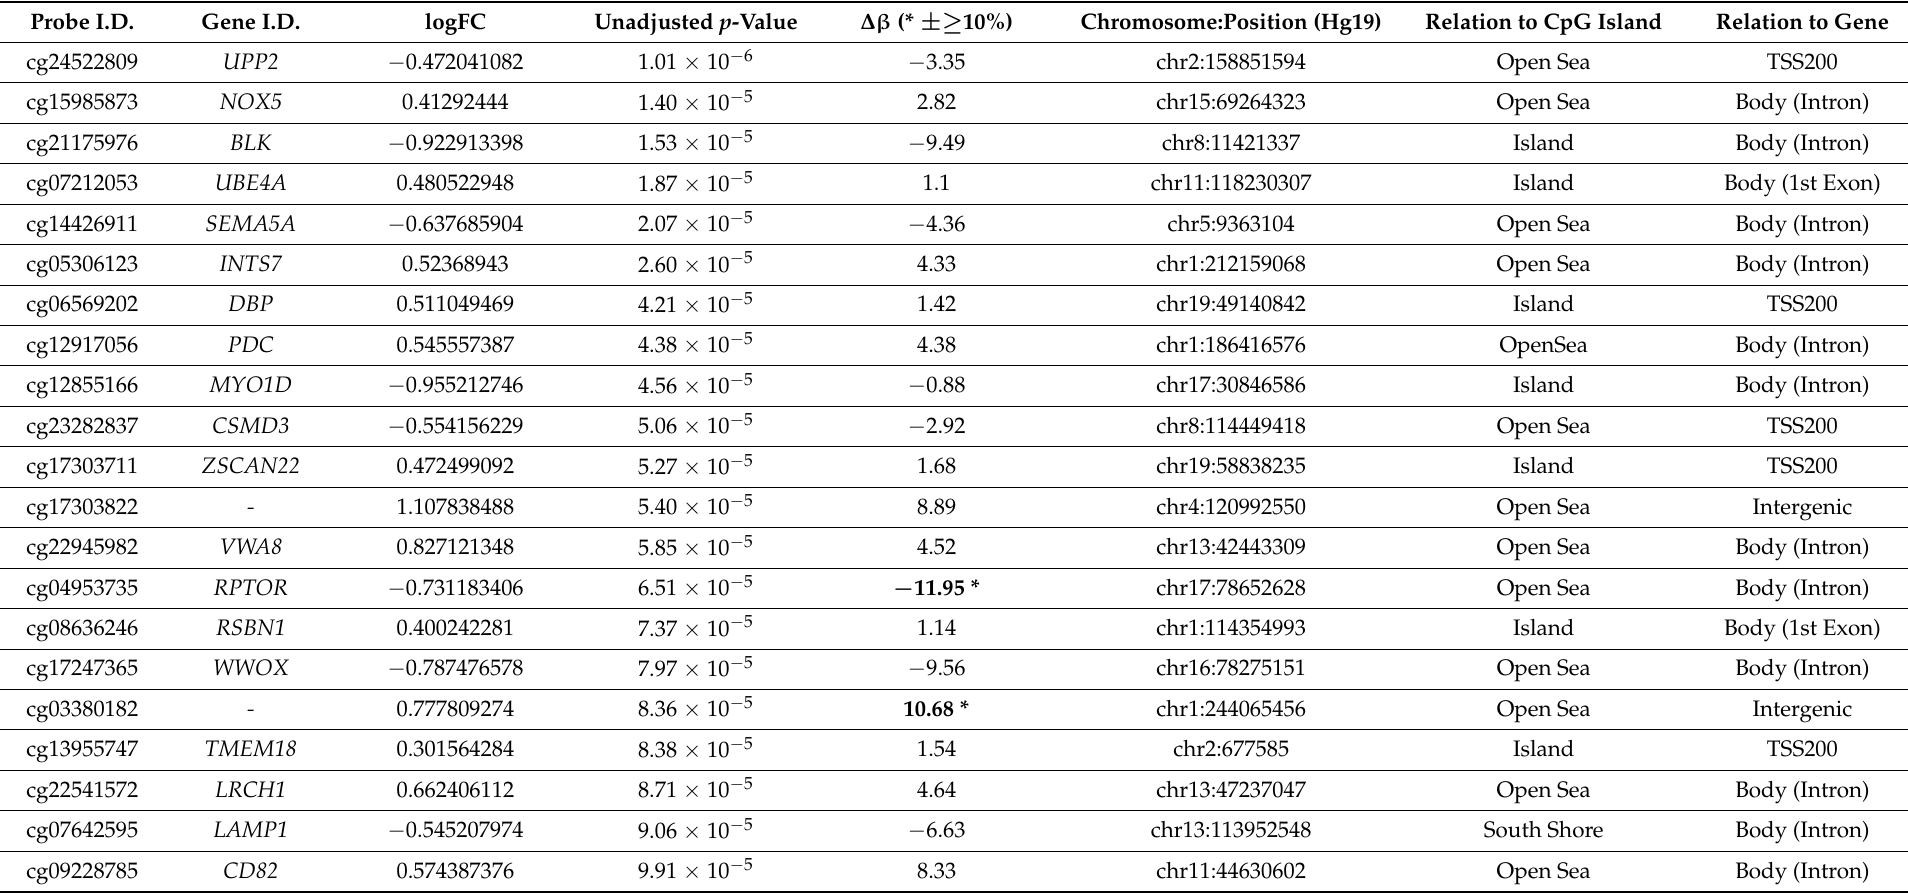
Table 1. Differentially methylated CpG probes identified in whole blood of patients with AMD using a relaxed p -value criterion ( p ≤ 10 − 4 ). Probe